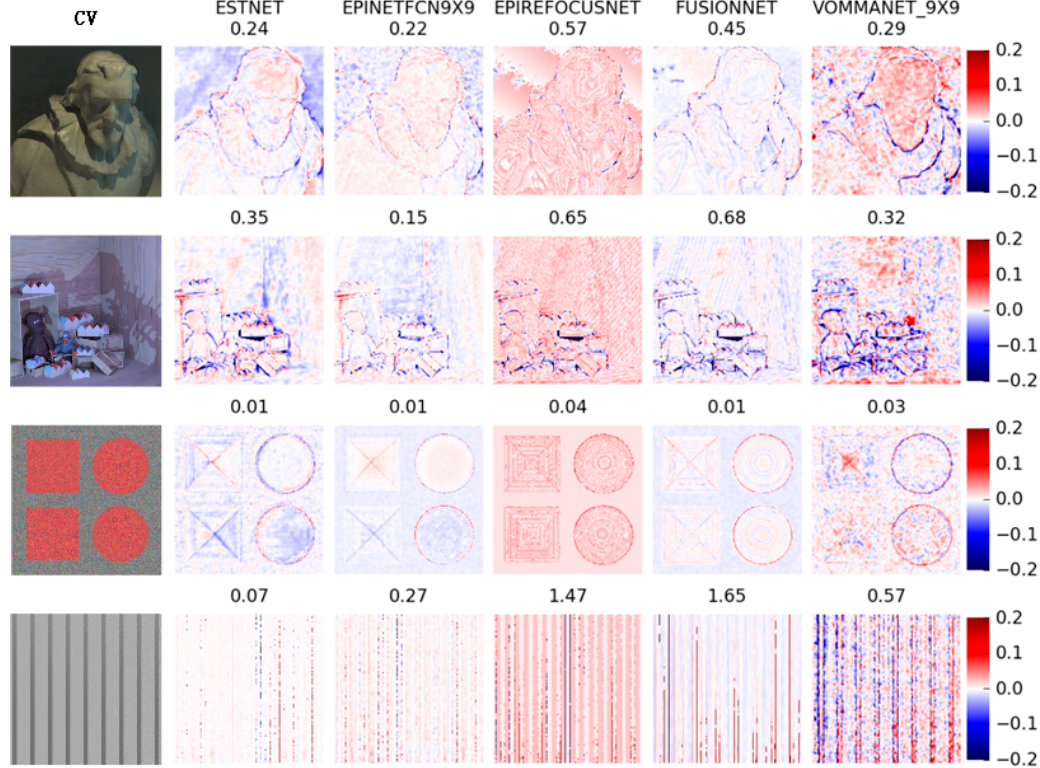
Figure 5. Examples of MSE results for each network.